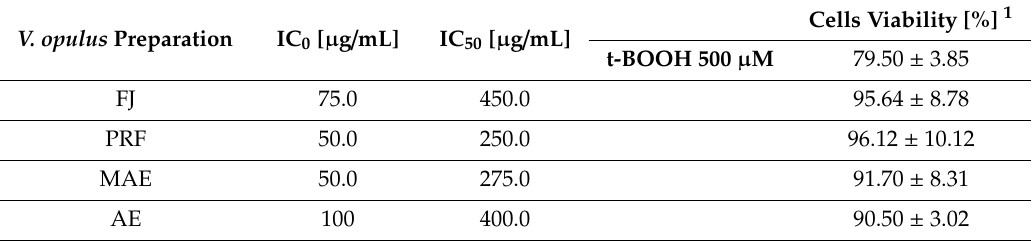
Figure 2. The influence of V. opulus extracts on Caco-2 cells on metabolic activity determined by PrestoBlue assay after 24 h exposure of juice (FJ) and PRF (phenolic rich fraction) ( A ), MAE (methanol-acetone extract) and AE (acetone extract) ( B ). Control cells were not exposed to any compound but the vehicle; values are means ± standard deviations from at least three independent experiments; statistical significance was calculated versus control cells (untreated) *** p ≤ 0.001. Table 3. The influence of Viburnum opulus fractions on Caco-2 cells viability presented as IC 0 and IC 50 values.